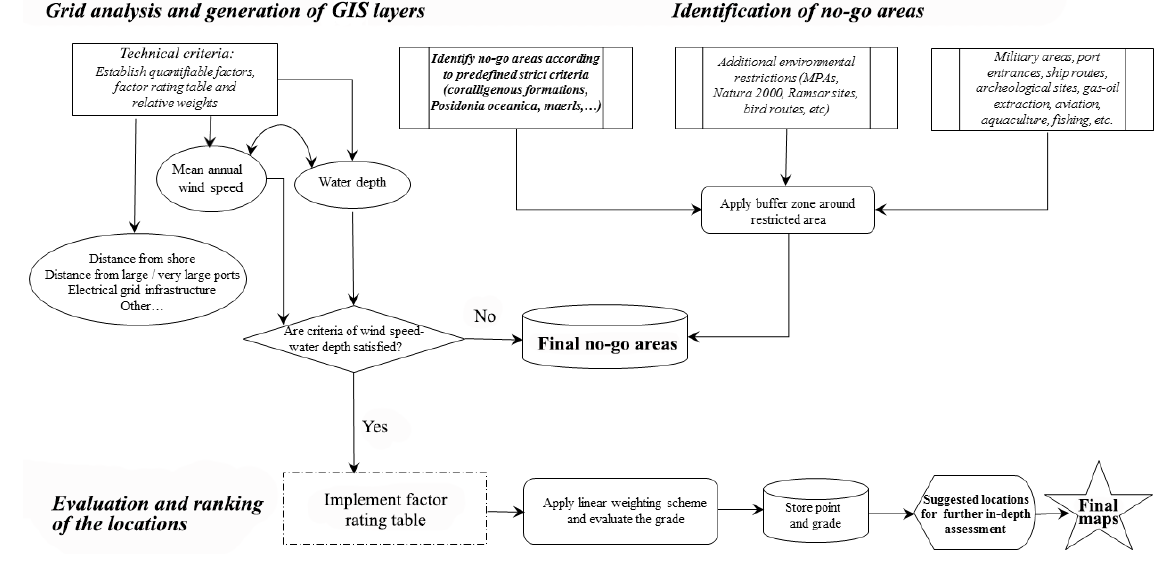
Figure 1. Flow chart for the development of the